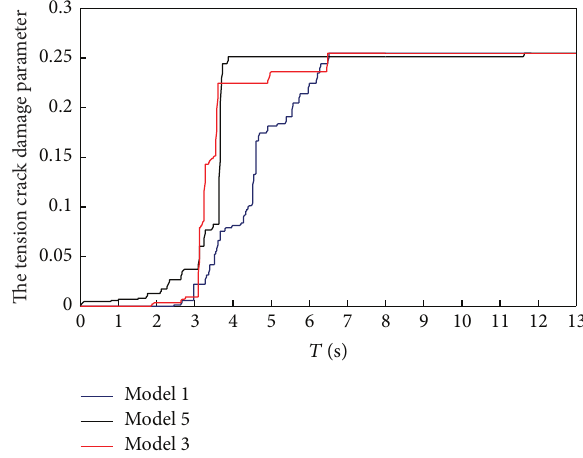
Figure 38: The tension crack damage parameter of spandrel under Wolong ground motion.